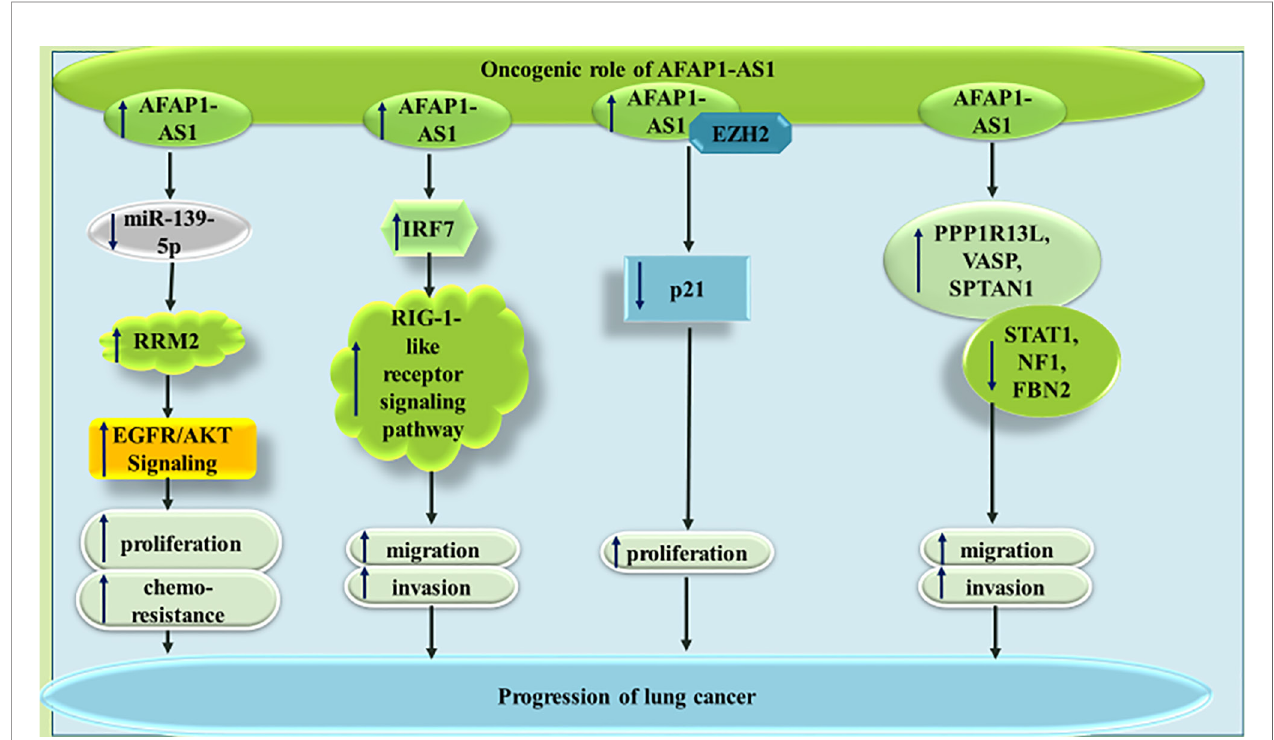
FIGURE 1 | The oncogenic role of AFAP1-AS1 in lung cancer through modulation of expressions of RRM2, IRF7, p21 and PPP1R13L. The effects of AFAP1-AS1 on RRM2 expression is mediated through sponging miR-139-5p. This mode of action results in enhancement of cell proliferation, migration and